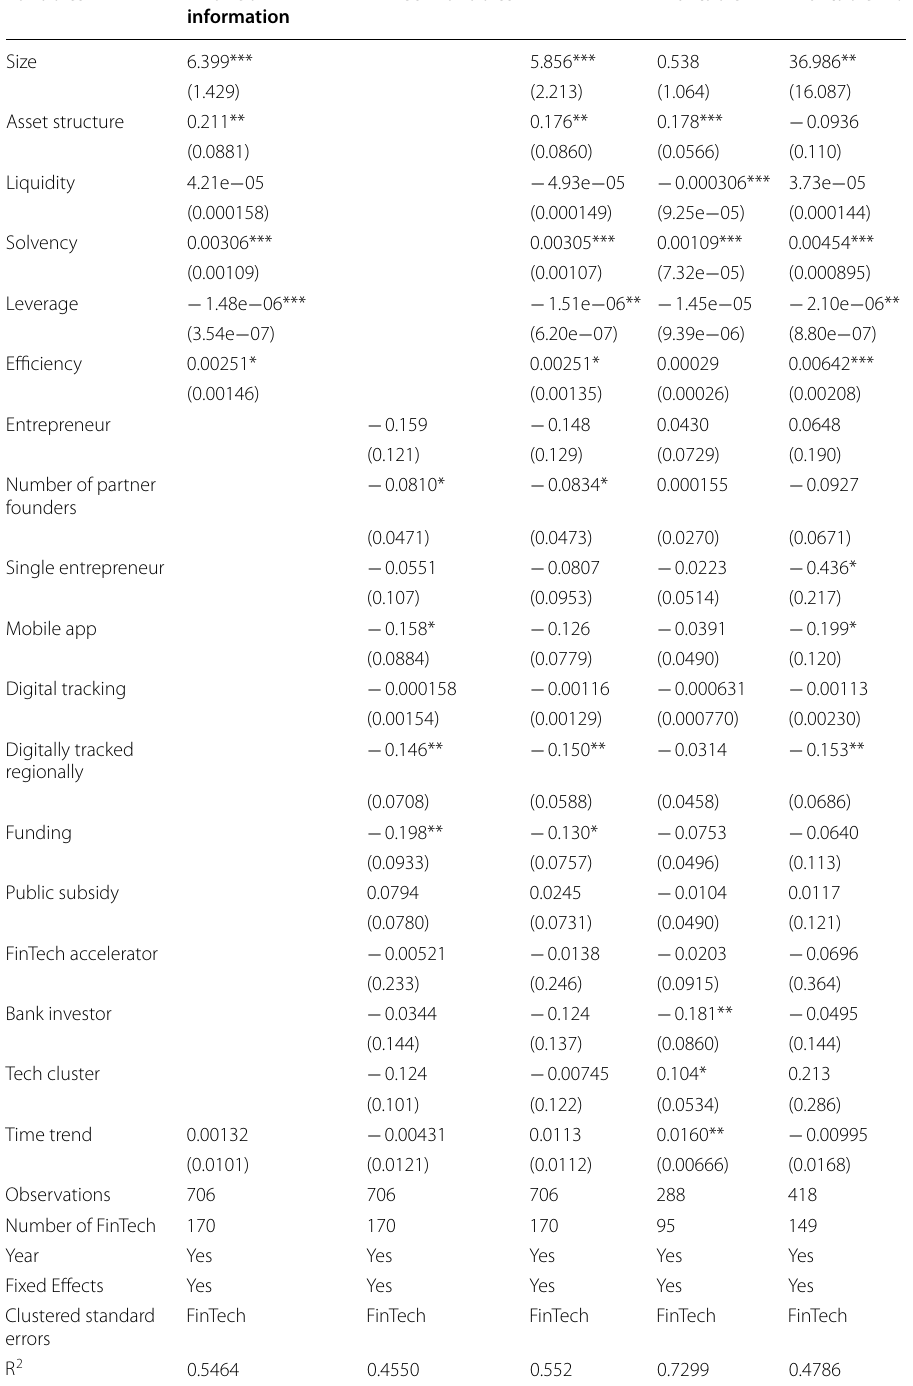
Table 8 The magnitude of FinTech company